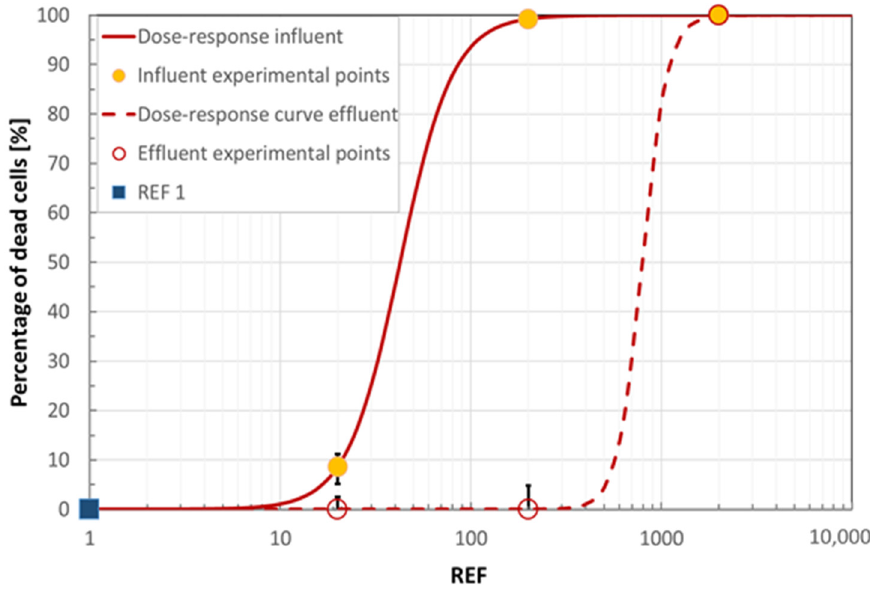
Figure 1. Cell viability in IAR203 hepatic cells exposed to different concentrations of influent and effluent wastewater extracts. Values are expressed as % versus the untreated (negative) control. Cell viability was assessed with Neutral Red Assay in triplicate: error bars show maximum and minimum values.